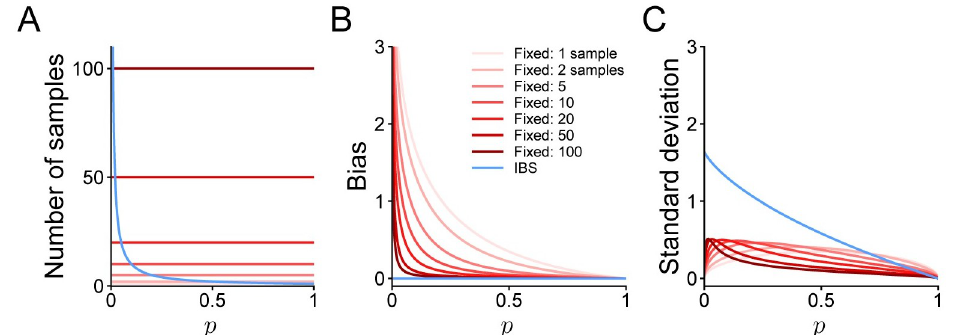
Fig 1. Properties of estimators. A . Number of samples used by fixed (red curves) or inverse binomial sampling (blue; expected value) to estimate the log-likelihood log p on a single trial with probability p . IBS uses on average 1 Bias of the log-likelihood estimate. The bias of IBS is identically zero. C . Standard deviation of the log-likelihood estimate.